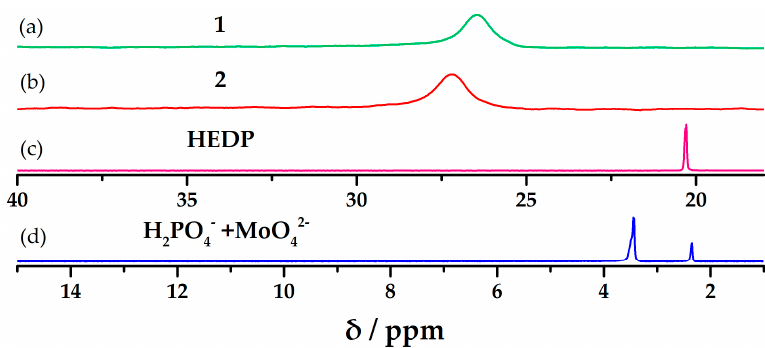
Figure 5. ( a ) solution 31 P NMR spectra of 1 ; ( b ) solution 31 P NMR spectra of 2 ; ( c ) Solution 31 P NMR